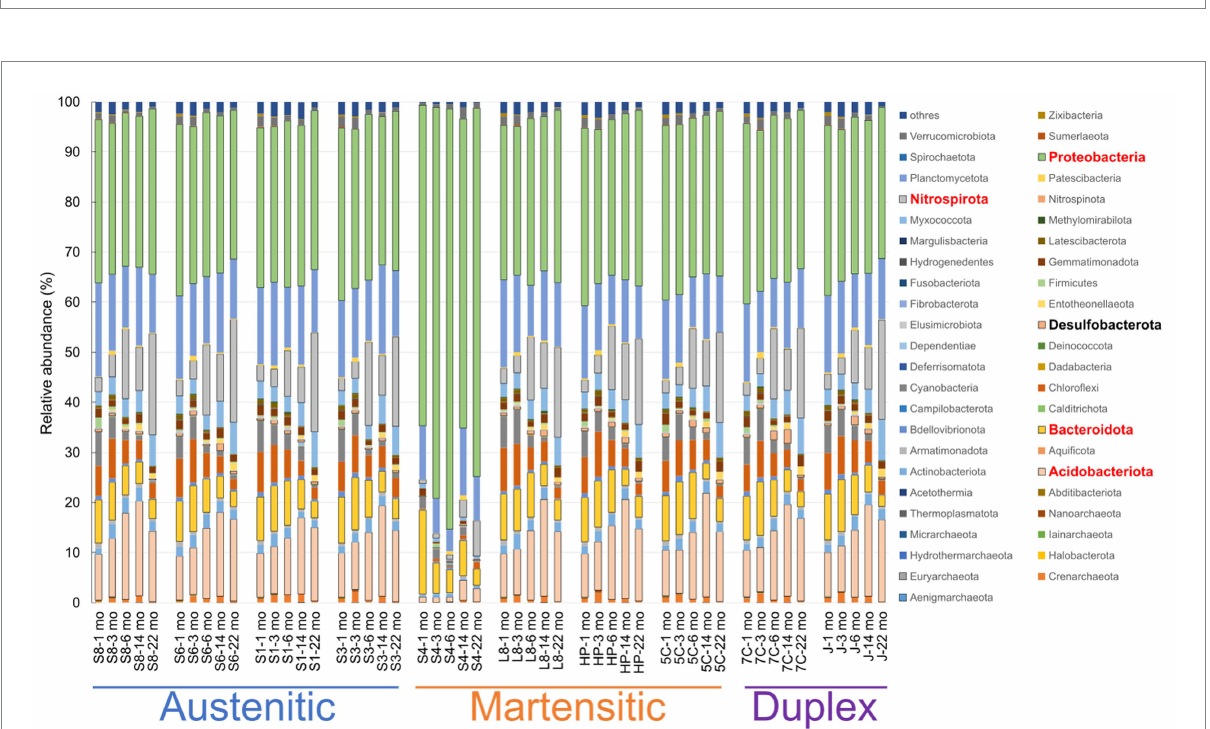
FIGURE 7 Relative abundances of microorganisms at phylum level in each sample. S8, S30400; S6, S31600; S1, Casting S31600; S3, S30300; S4, S40300; L8, S42000; HP, S41426; 5C, 15% Cr; 7C, 17% Cr; and J,